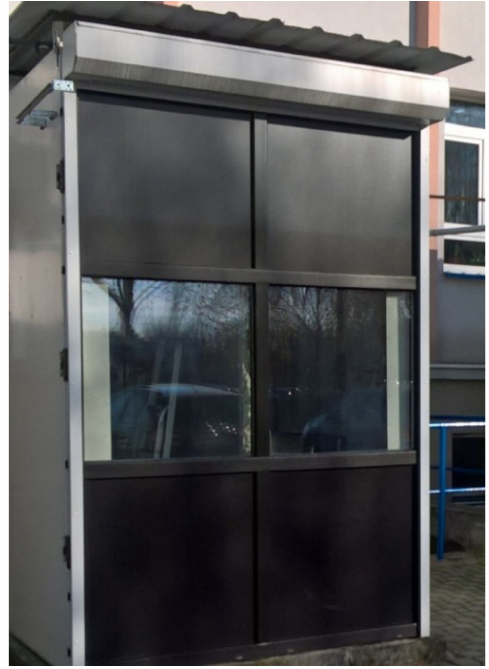
Figure 5. Photograph of the field test